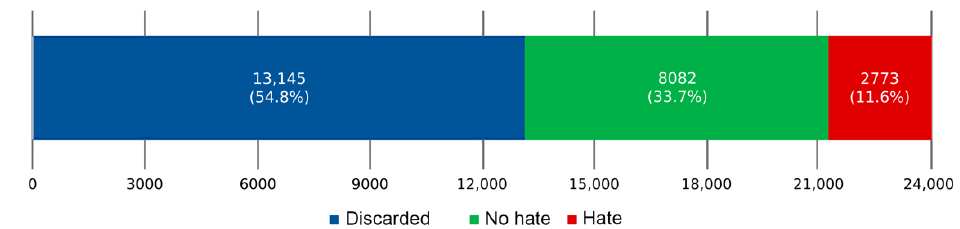
Figure 1. Frequencies and percentages of manually classified political tweets.